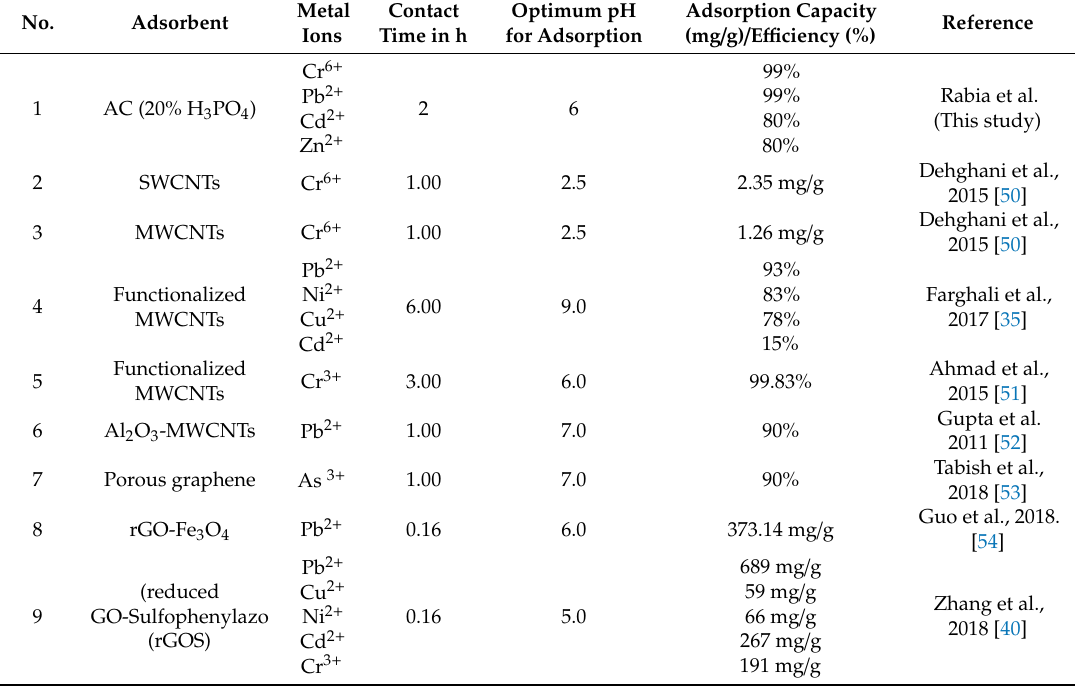
Table 3 . Comparison of the activated carbon with other carbon nanomaterials in the treatment of heavy-metal-contaminated water .